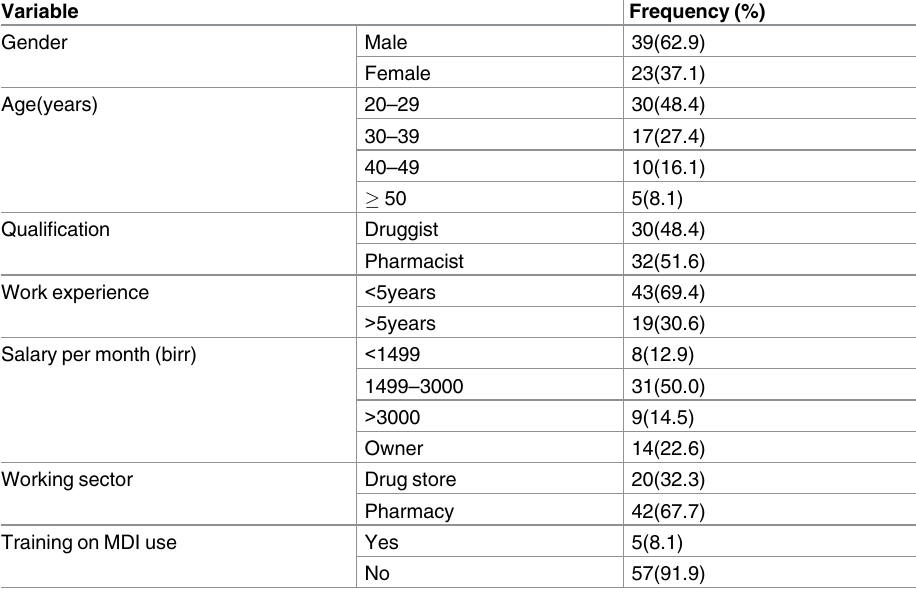
Table 2. Socio-demographic characteristics of the respondents, Gondar, 2017 (N =